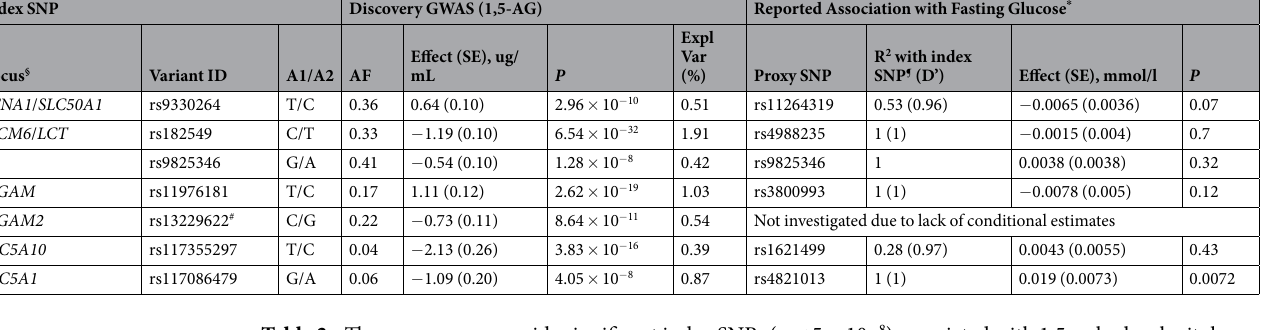
Table 2. The seven genome-wide significant index SNPs (p < 5 × 10 − 8 ) associated with 1,5-anhydroglucitol in 7,550 European American subjects from the ARIC study. * The association result with fasting glucose was extracted from the published MAGIC Consortium GWAS result 11 . § The gene closest to the variant and other candidate genes are listed (index gene). ¶ R 2 information was calculated from the 1000 Genomes Project Phase 3 in European (EUR) population. # rs13229622 is an independent SNP with genome-wide significant association with 1,5-AG found through conditional analysis. A1 is the effect allele, i.e. the allele for which effect estimates are provided. Abbreviations: AF = effect allele frequency; SE = standard error; Expl Var = proportion of 1,5-AG variance explained.